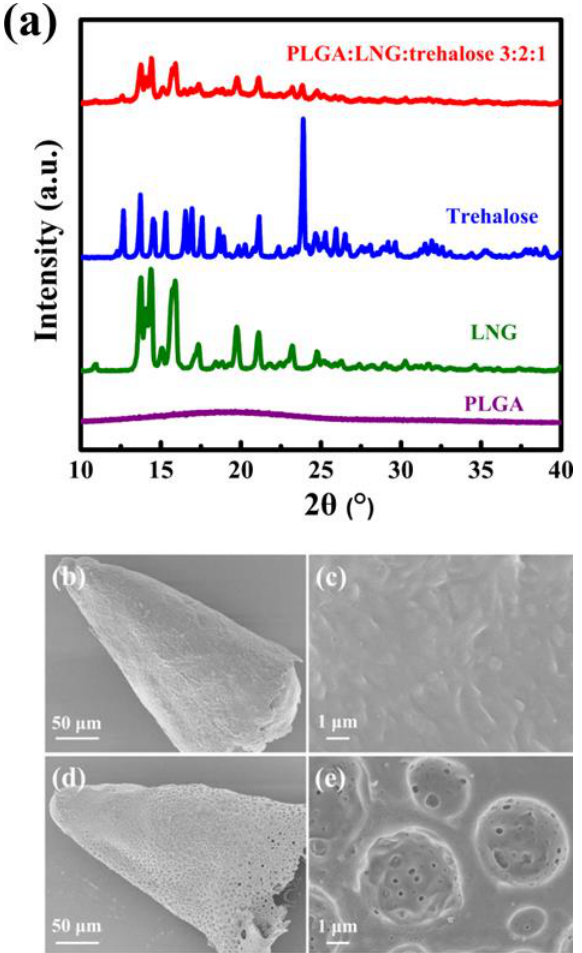
Figure 6. ( a ) XRD patterns of PLGA, LNG, trehalose (dehydrate) and the dried powder of PLGA arrowhead matrix (containing PLGA:LNG:trehalose with a mass ratio of 3:2:1). ( b – e ) Morphologies of PLGA arrowheads with or without trehalose after immersion in water: ( b ) PLGA arrowhead without trehalose, ( c ) enlarged picture of ( b ), ( d ) PLGA arrowhead with 33.3% trehalose, ( e ) enlarged image of ( d ).